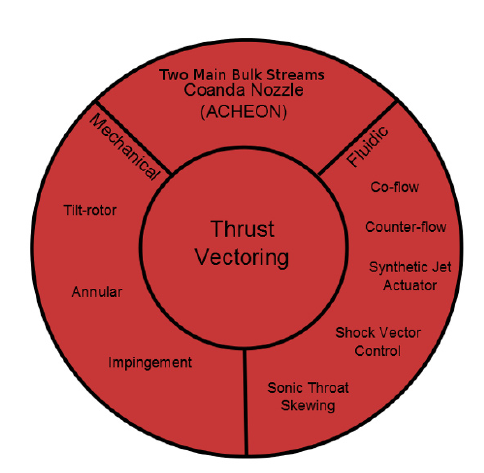
Figure 3. Classification of thrust vector systems proposed for air vehi- cles.